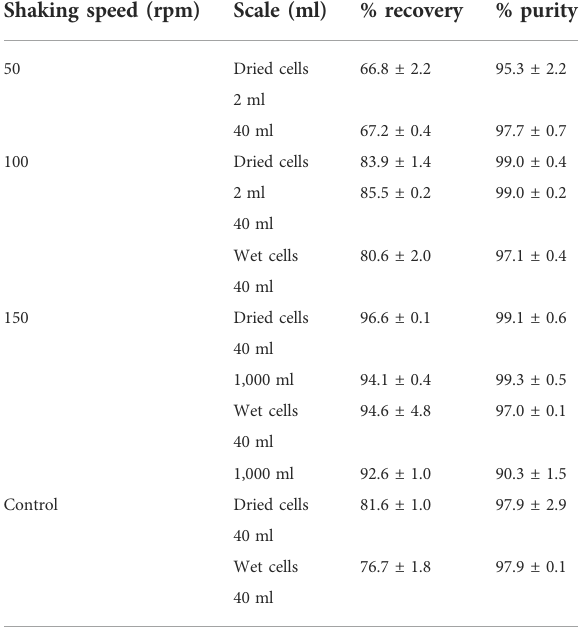
TABLE 2 Effect of shaking speed of the water bath on PHB extraction from dried and wet cells using 1,3-dioxolane. Shaking speed